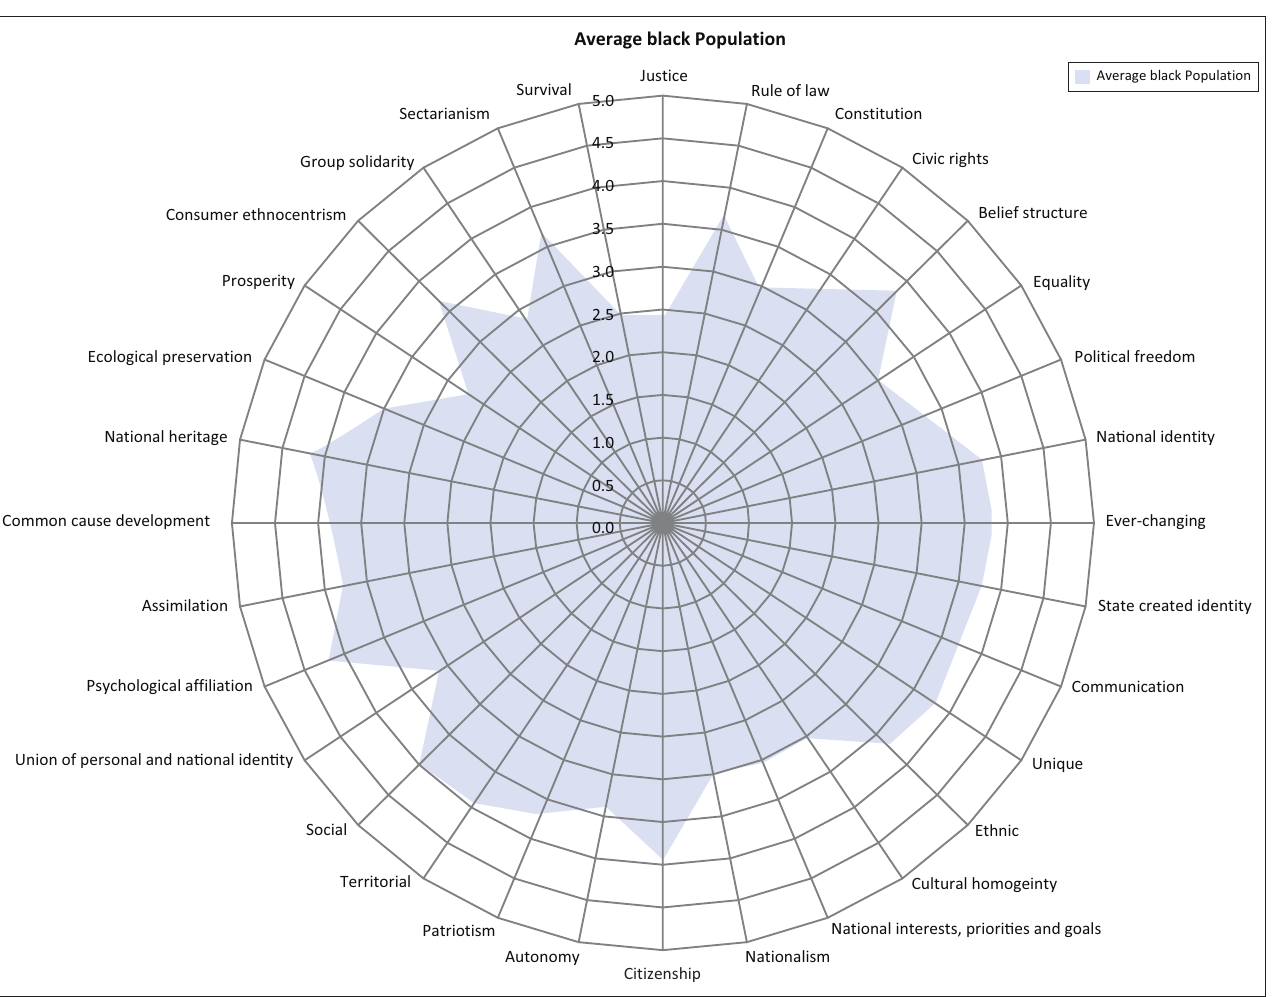
indicators of national identity for the black respondents as shown in Figure 5.